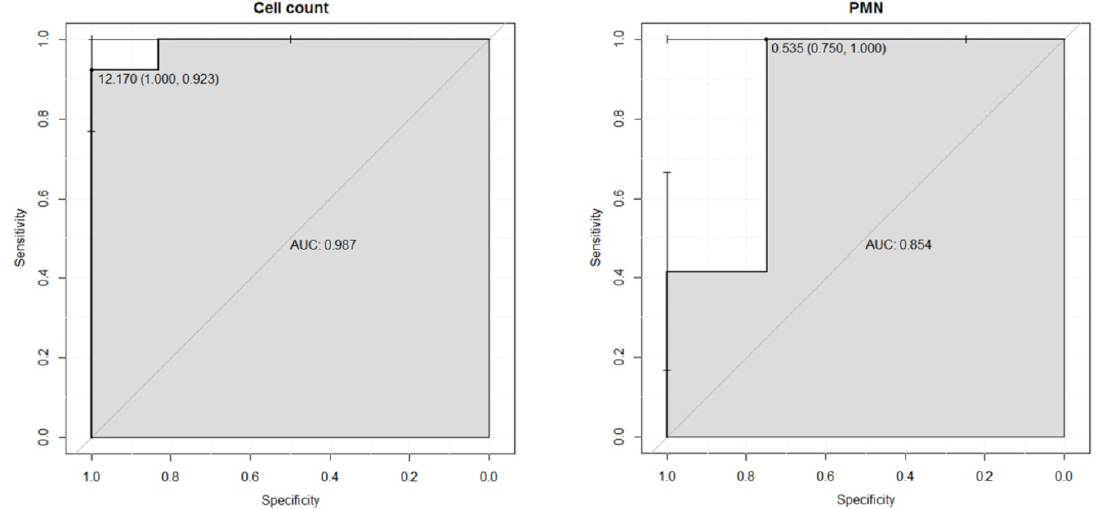
Figure 1. ROC curves for cell count and differential of polymorphonuclear leukocytes